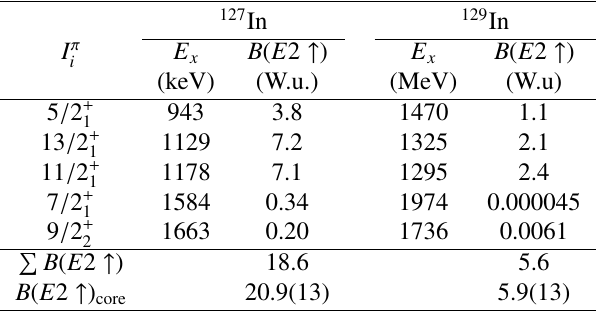
Table 4. Calculated B ( E 2) values for In isotopes. Core B ( E 2) values are from Refs. [5, 6].